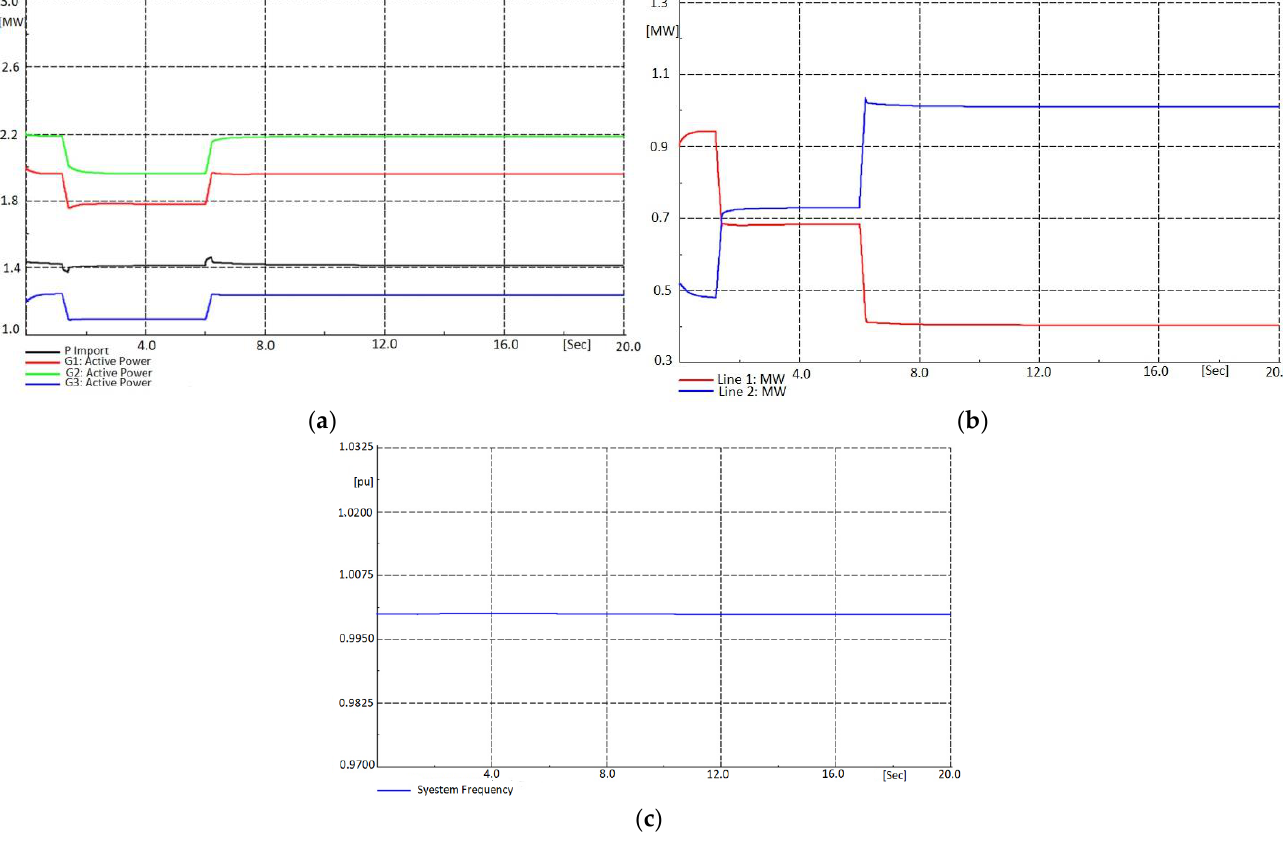
Figure 7. Simulation results of Case study-1. ( a ) Active Power of SG1, SG2 and SG3; ( b ) Active Power Flow on Line 1 and Line 2; ( c ) Frequency of the Micro Grid.